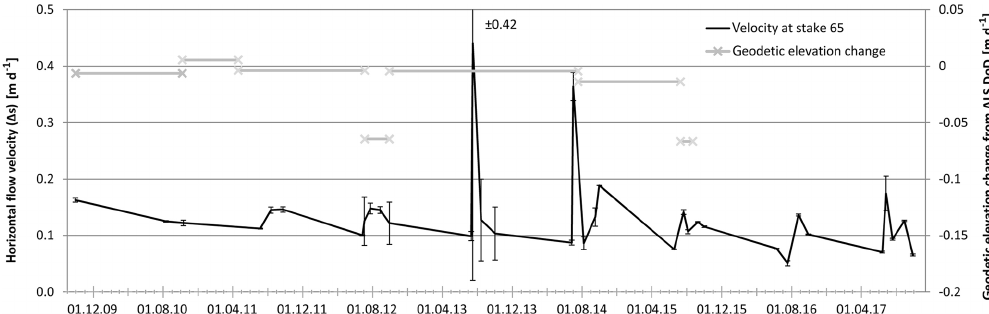
Figure 7. Mean daily horizontal velocities ( (cid:49)s d − 1 ) at Stake 65 on Gepatschferner between the measurements, as an example of the sub- seasonal fluctuation of surface velocity. The peak in July 2013 shows the highest uncertainty, very likely because of few satellites due to shading effects of the surrounding topography, which depend on the time of the measurements. Additional information is given by the mean elevation change per day from ALS DODs at the position of the stake (data extended from Stocker-Waldhuber et al.,